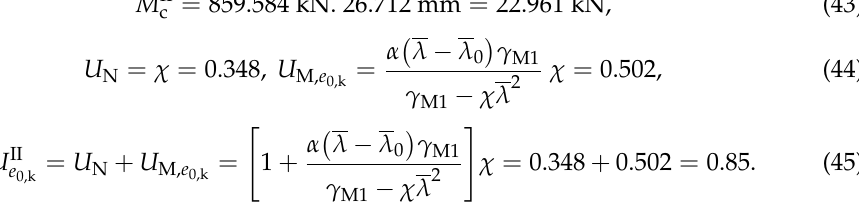
Table 4. Results of the second-order theory for flexural buckling perpendicular to weak axis z–z.